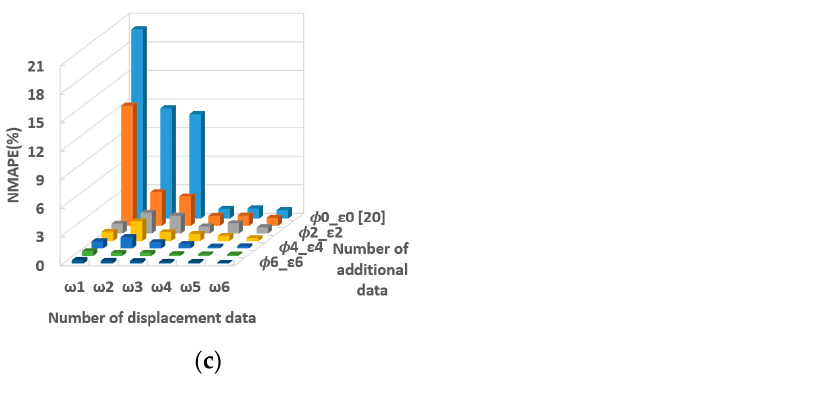
Figure 21. NMAPE according to the number and combination of sensors (RDS2): ( a ) displacement + slope, ( b ) displacement + strain, ( c ) displacement + slope + strain.